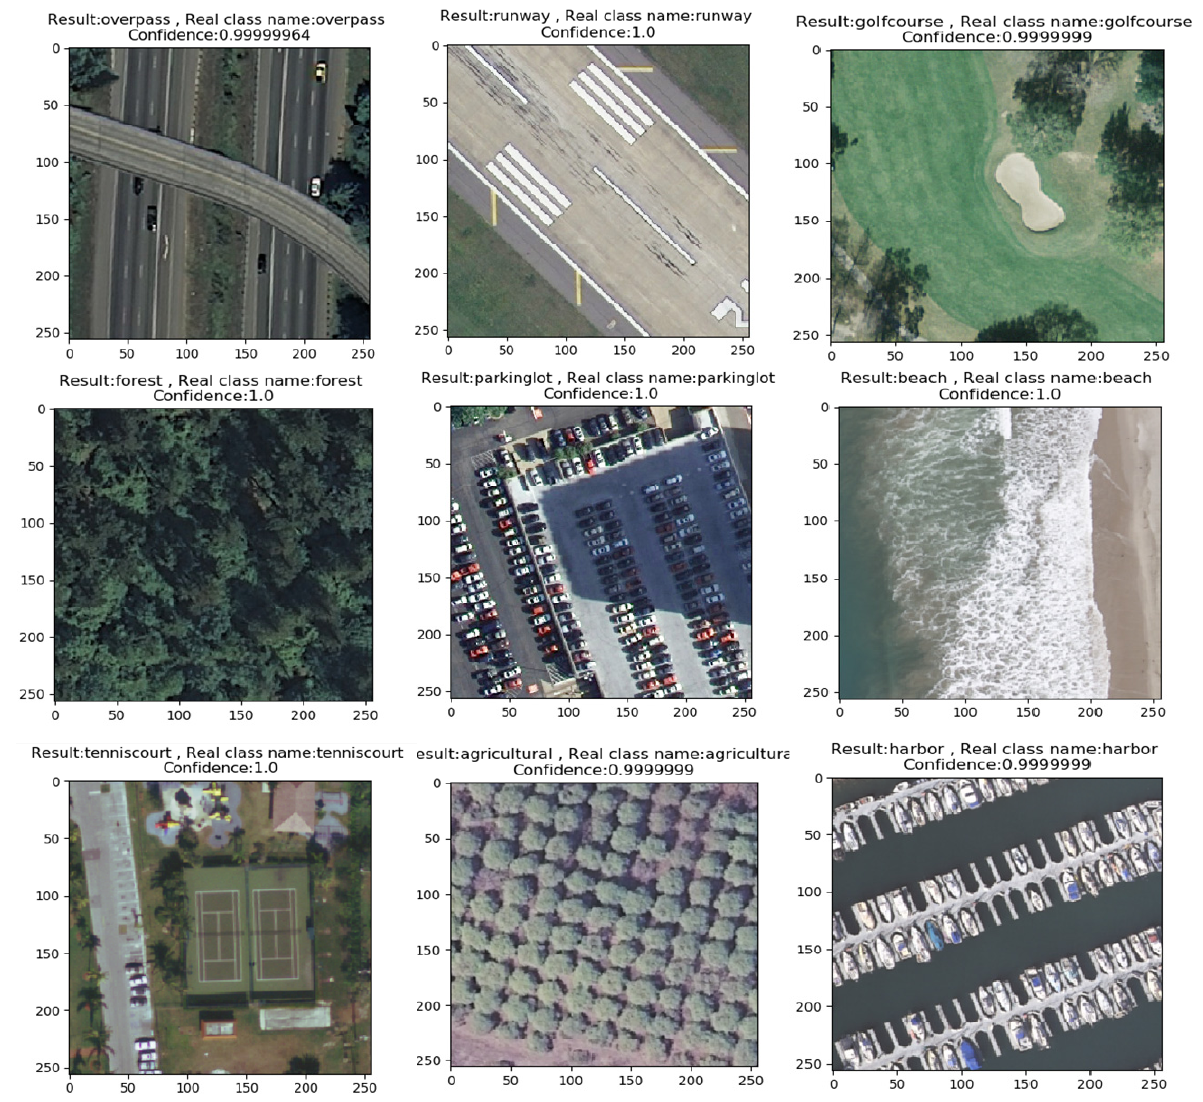
Figure 16. Random image test results.